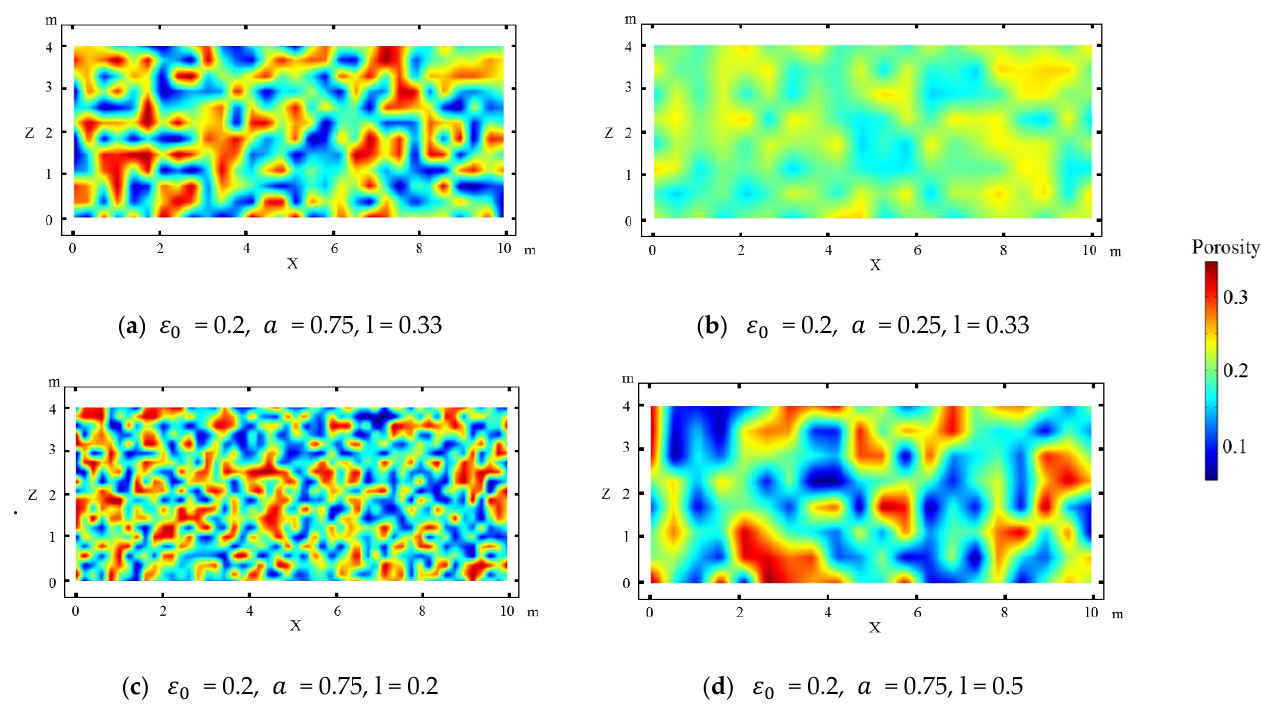
Figure 1. Initial porosity distribution under different scenarios.